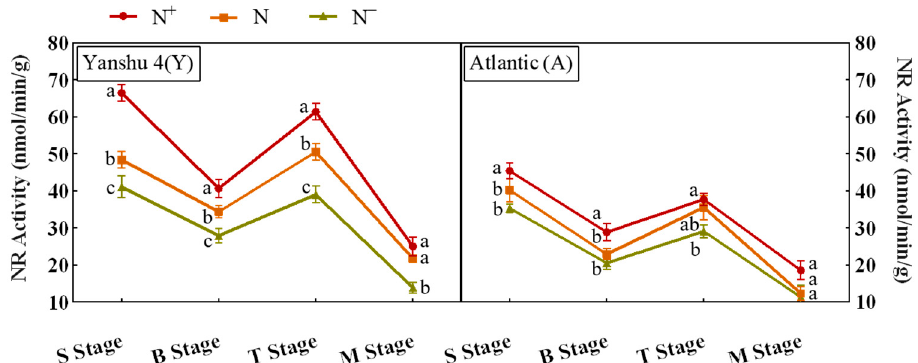
Figure 15. Nitrate reductase (NR) activity in two genotypes of potato leaves under different N supply levels. The amount of catalytic reduction of 1 nmol of NADH per 1 g of fresh weight sample per 1 min is one unit of enzyme activity. S Stage, B Stage, T Stage, and M Stage represent seedling stage, budding stage, tuber expansion stage, and mature stage, respectively. N − , N, N + are different N supply levels, representing low N, normal N, and excess N, respectively. Different letters indicate the difference of enzyme activity under different N application levels in the same period ( p < 0.05).